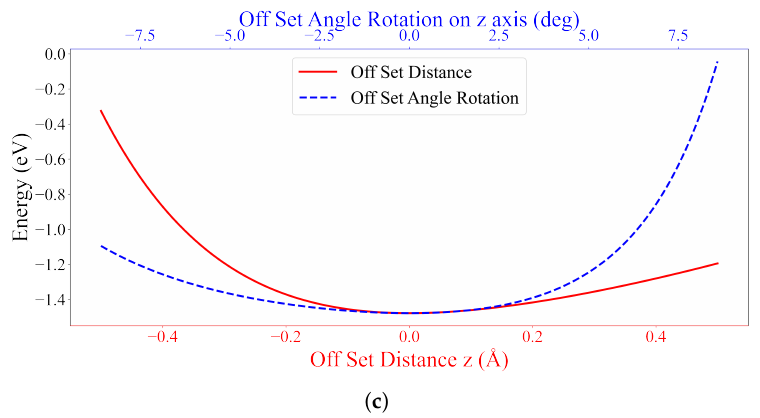
Figure 4. Energy values of ( a ) seed II-5 for Type A1, ( b ) seed III-2 for Type A2 and ( c ) seed III-3 for Type A3 with offset positions in the z -direction (Å) and offset angles on the z -axis (degrees) between two DOXHs.